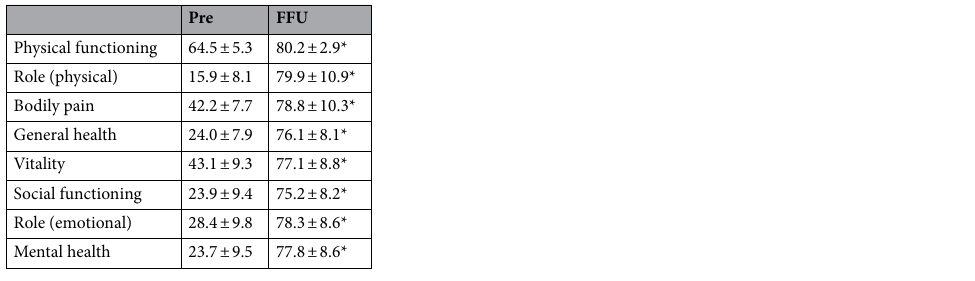
Table 3. Quality of life according to SF-36 scale (average ± standard deviation). *Analyzed by paired t test, compared with preoperatively, p < 0.05. Pre preoperative, FFU final follow-up.